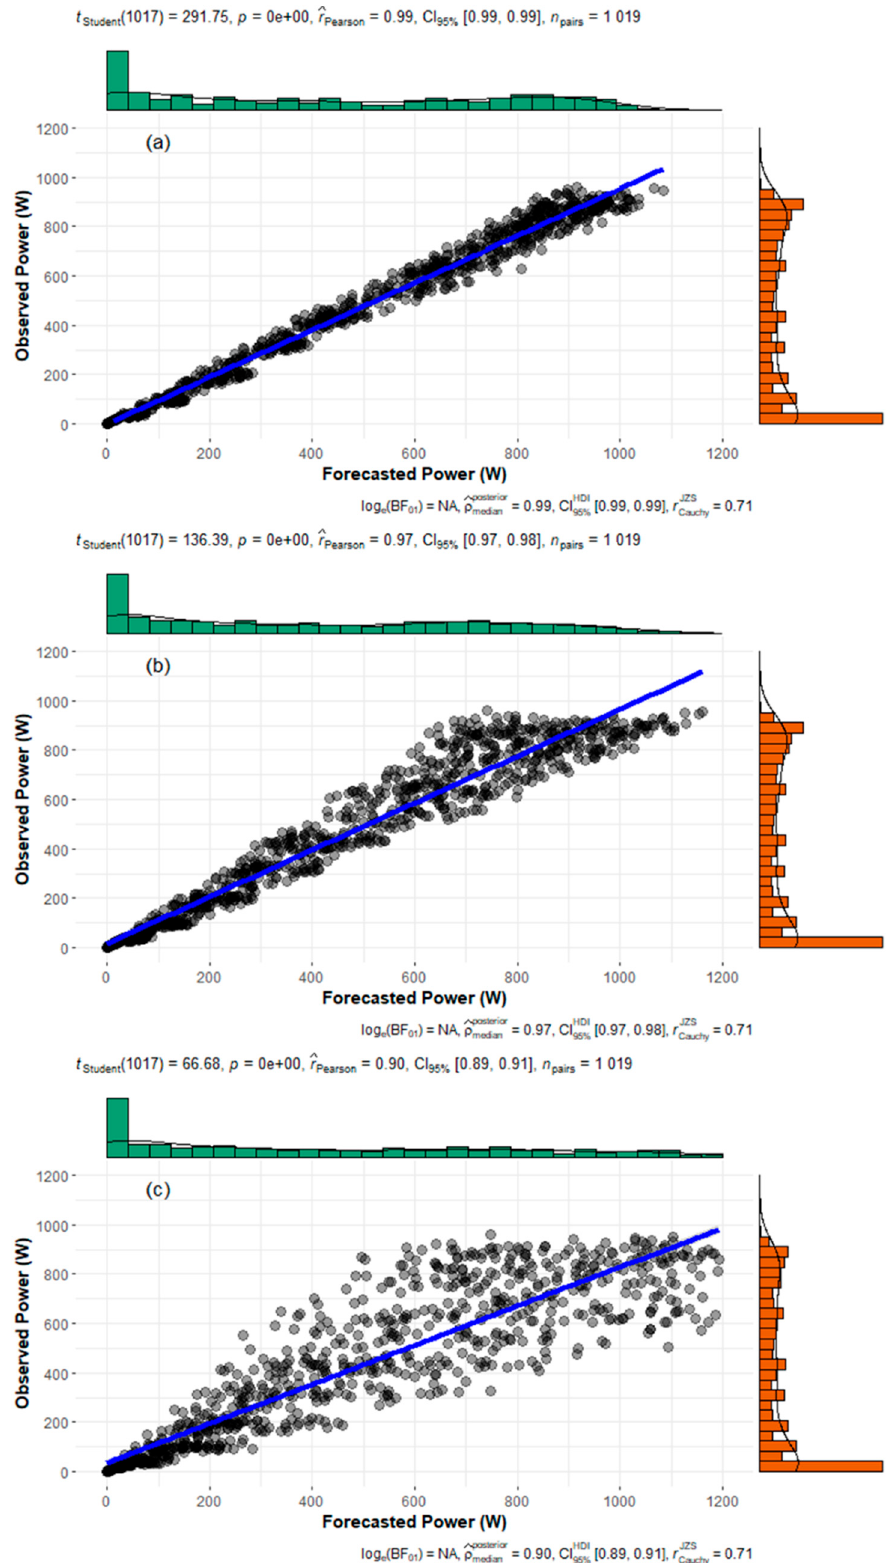
Figure 7. Scatter plots of the observed against forecasted power for the: ( a ) Bayesian neural network (BNN); ( b ) support vector regression (SVR); ( c ) regression tree (RT). The blue line demonstrates the linear fit.